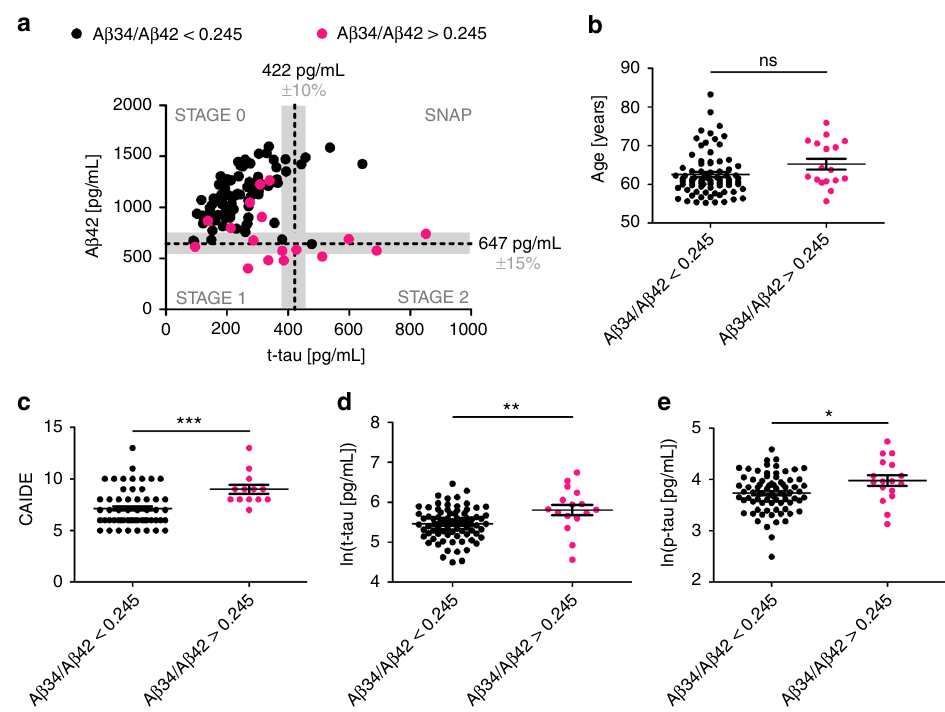
Fig. 7 A β 34, A β 42, t-tau, and p-tau in PREVENT-AD. a – e PREVENT-AD Study: analysis of A β 34, A β 42, t-tau, and p-tau in CSF samples from cognitively normal individuals at risk for Alzheimer ’ s disease ( n = 94). a Individuals can be separated into stages of pre-symptomatic AD, based on CSF biomarker assessment (t-tau cut-off > 422 pg/mL 49,50 , A β 42 cut-off ≤ 647 pg/mL 41 , the gray shaded area indicates common inter-assay variances of the used cut- off values 41,51 ). STAGE 0: t-tau and A β 42 normal; STAGE1: t-tau normal and A β 42 ≤ 647 pg/mL; STAGE 2: t-tau> 422 pg/mL, and A β 42 ≤ 647 pg/mL; Suspected-non-AD pathology (SNAP): t-tau> 422 pg/mL and A β 42 normal. Individuals with A β 34/A β 42 ratio above the optimal cut-off calculated in this study (A β 34/A β 42 > 0.245) are highlighted in magenta. b – e Comparison of age, Mann – Whitney U = 461.5, p = 0.0586 ( b ); Cardiovascular Risk Factors, Aging, and Incidence of Dementia (CAIDE), Mann – Whitney U = 184.5, p = 0.0004 ( c ); t-tau, unpaired t-test t(92) = 3.027, p = 0.0032 ( d ); and P 181 -tau (p-tau), unpaired t -test t (92) = 2.453, p = 0.0168 ( e ); between individuals with A β 34/A β 42 ratios above and below optimal cut-off (*** p < 0.001, ** p